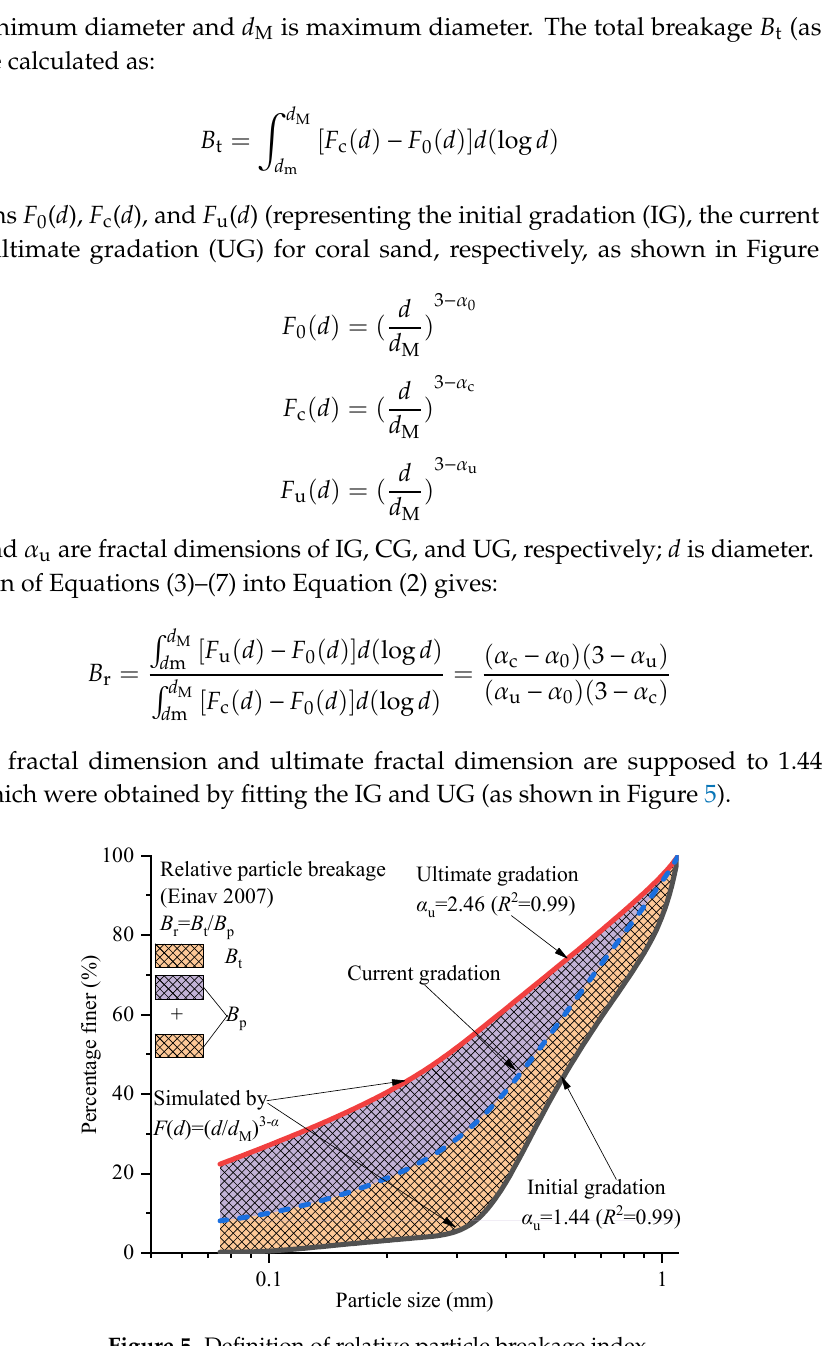
Figure 5. Definition of relative particle breakage index.